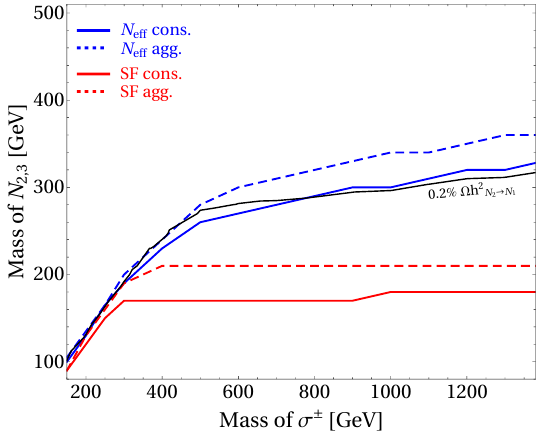
Figure 3 . Constraints from structure formation (red curves) confronted with N e(cid:11) limits (blue curves) derived using eq. (3.21). The solid curves correspond to the conservative and dashed ones to the aggressive choice of (cid:1) N e(cid:11) . Note that structure formation limits also indirectly depend on (cid:1) N e(cid:11) as it is an input parameter for CLASS . Clearly, N e(cid:11) yields much stronger limits in comparison to those arising from structure formation. Shown in black is the curve for (cid:10) h 2 Current measurements by the Planck collaboration allow for an upper limit of (cid:1) N e(cid:11) 0 : 28 at 95% CL (TT, TE, EE+lowE+lensing+BAO). Including the present tension in the Hubble constant measurement, this value increases to (cid:1) N e(cid:11)